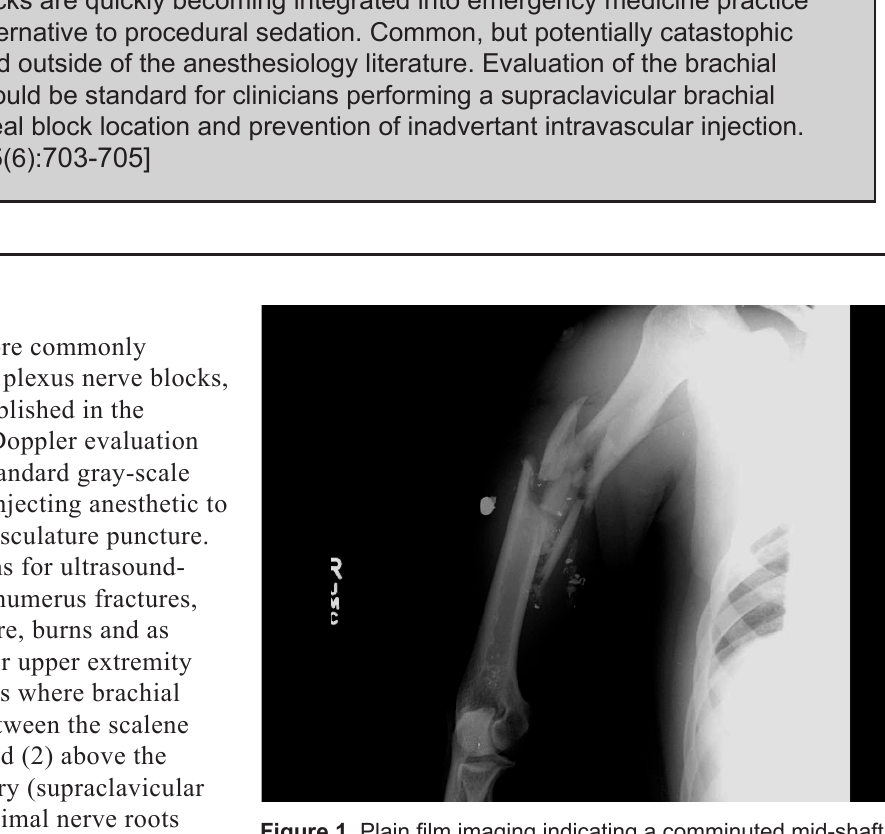
Figure 1. Plain film imaging indicating a comminuted mid-shaft humeral